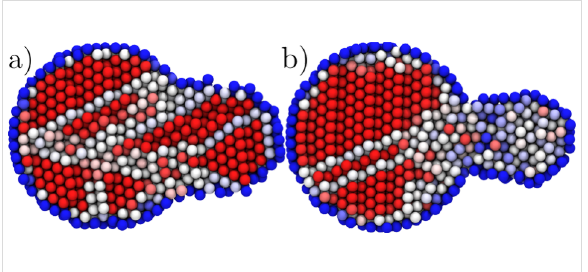
Figure 1: Two observed modes of plasticity. (a) Snapshot of the extru- sion from a 15.6 Å orifice showing the displacive plasticity (b) The same from a 11.6 Å orifice showing the amorphous region about the orifice. Atoms coloured by the centrosymmetry parameter, from red (= 0, fcc) to blue (>25, surface).